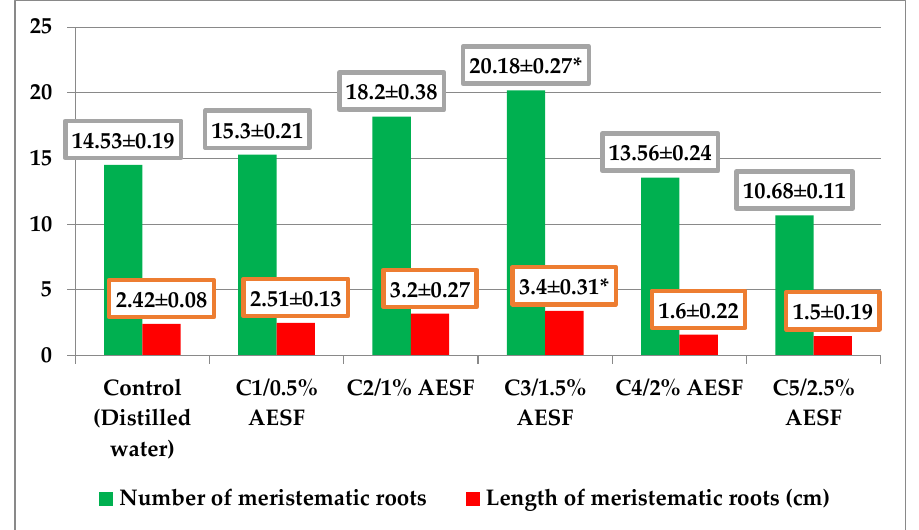
Figure 2. Graphical representation of the macroscopic effects induced by different concentrations of AESF for the A. cepa species (average values ± standard error of mean-SEM). * significant at p ≤ 0.05, compared to the control (LSD test at a probability level of 0.05% subsequent to ANOVA analysis).